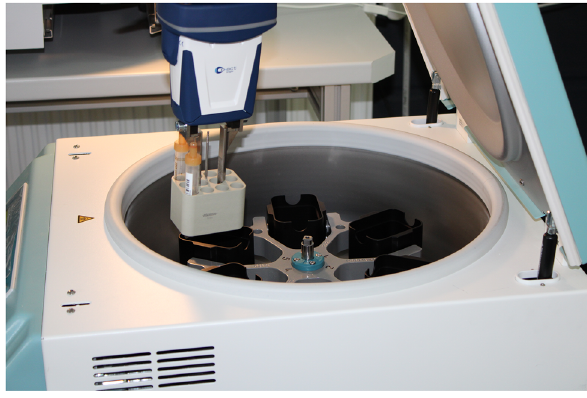
Figure 3: Robot interaction with